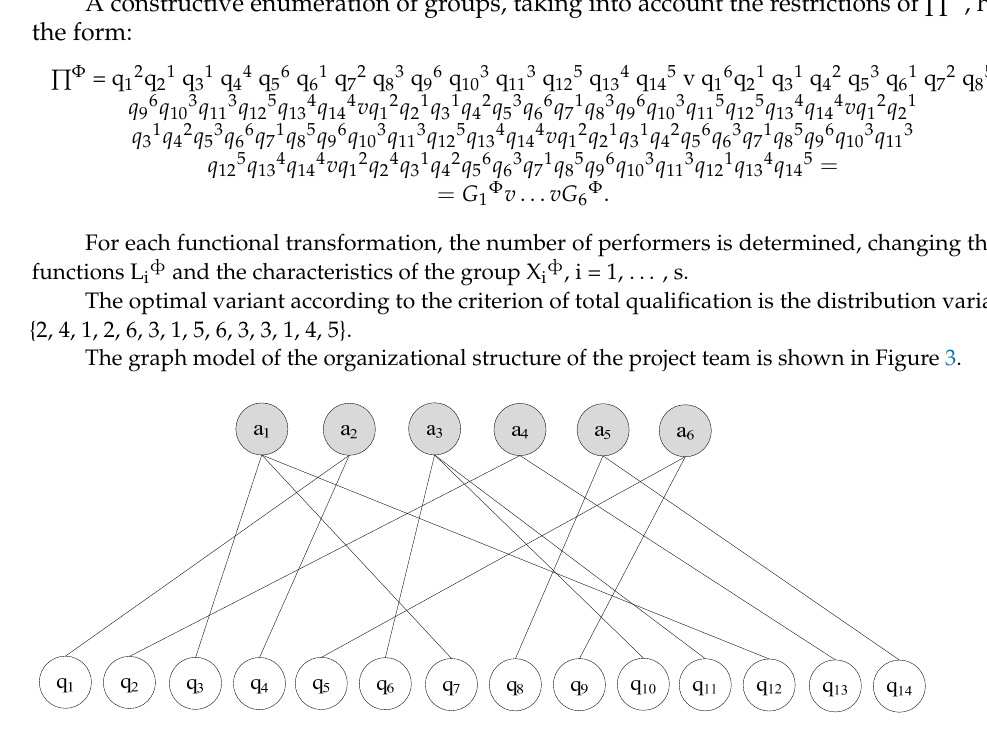
Figure 3. The graph model of the organizational structure of the project team.